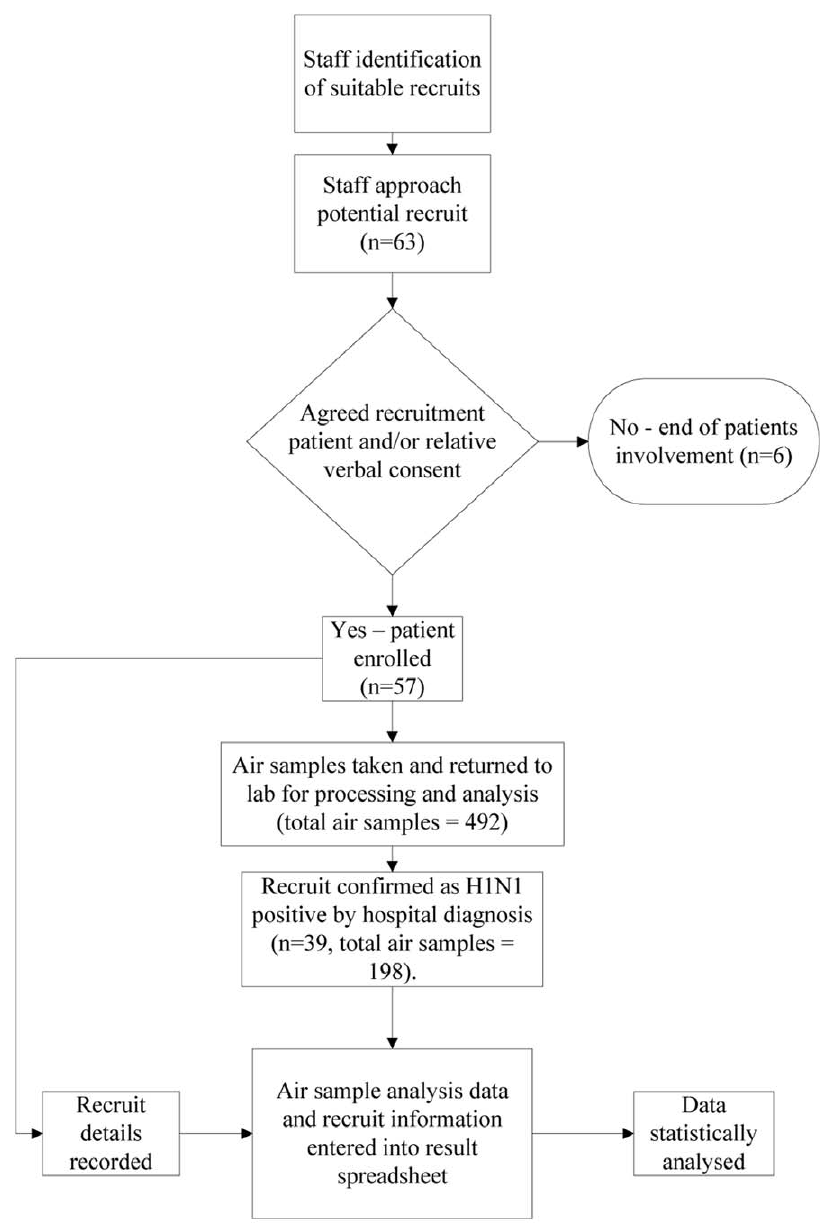
Figure 1. The recruitment and data analysis flowchart.